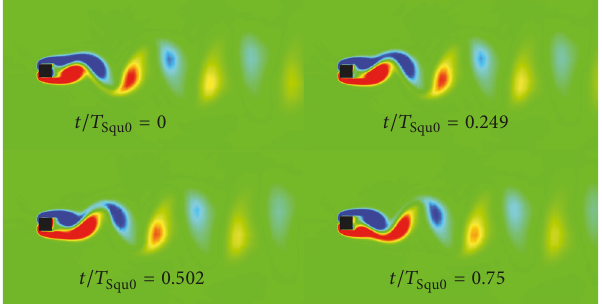
Figure 18: Vortex structures in synchronization region for 𝛼 = 15 ∘ / 𝛼 = 75 ∘ .